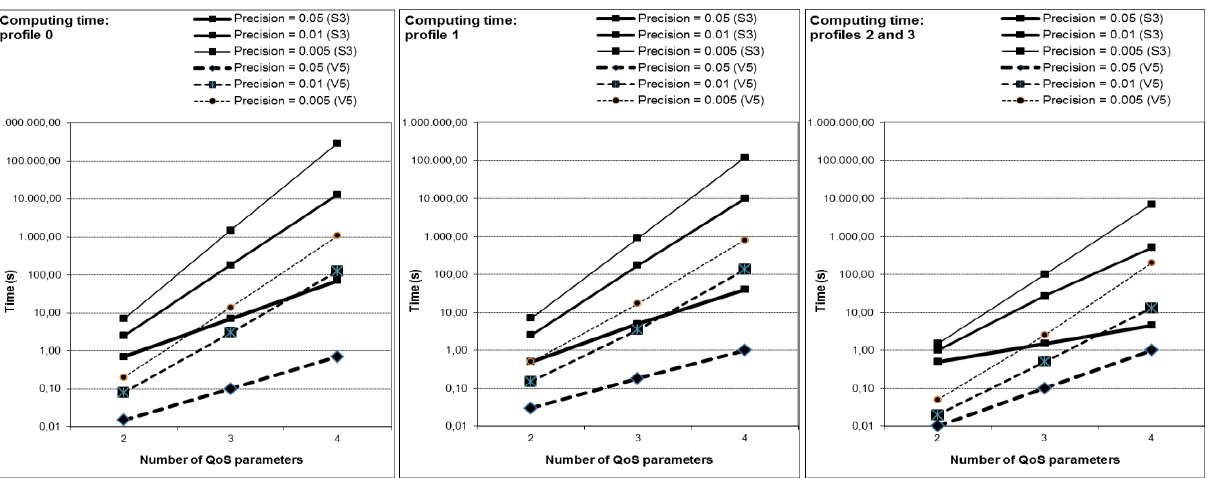
Figure 8. Experimental results: Computing times, for each profile, precision and